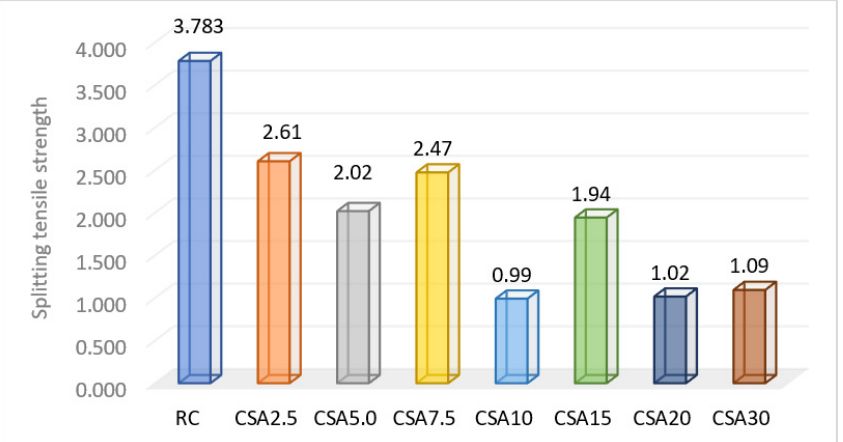
Figure 12. Splitting tensile strength of the composite samples (N/mm 2 ).